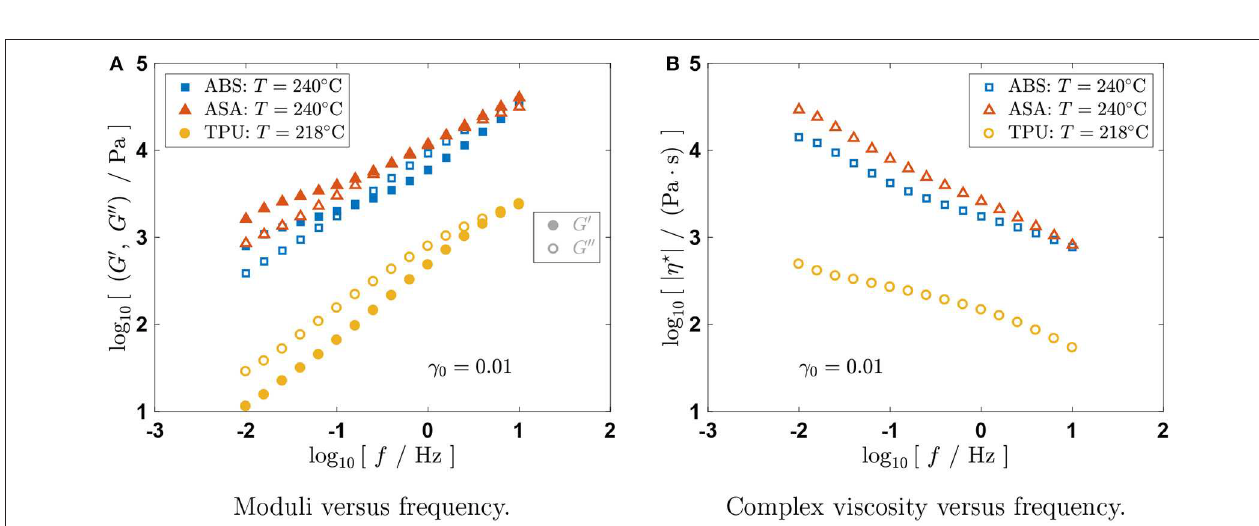
FIGURE 3 | Rheological characterization. (A) Moduli [ Pa ] vs. frequency [ Hz ] . The moduli of TPU at its print temperature are significantly lower than the moduli of both ABS and ASA. (B) Complex viscosity [ Pa · s ] vs. frequency [ Hz ] . The viscosity of TPU at its print temperature is significantly lower than the viscosity of ABS or ASA at each specific print temperature. This behavior reveals that TPU can flow much more easily than either acrylonitrile plastic during print. composites that were made with ABS and TPU. Published data ABS and TPU was 15% greater than the reported strength of the commercial adhesive, while the adhesive strength between 3D- printed ASA and TPU was 3% less. During the lap shear tests that were printed with ABS or ASA substrates and a TPU (bonded) joint, the TPU disbonded from the top substrate, with regards to the layer-by-layer printing. Thus, TPU appeared further